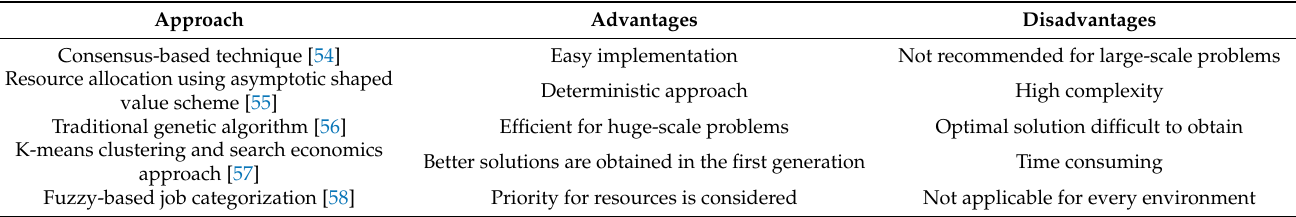
Table 2. Summary of Existing